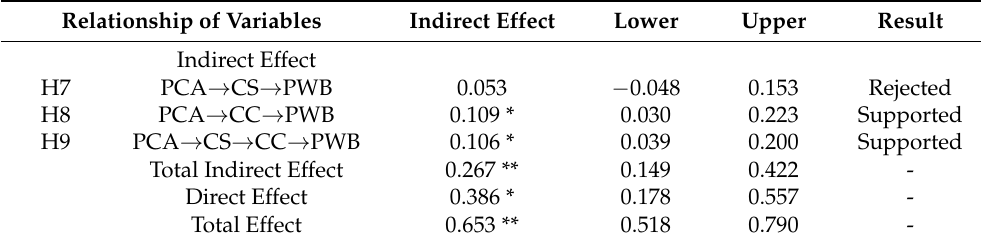
Table 5. Results of indirect effect analysis of the proposed model. Relationship of Variables Indirect Effect Lower Upper Result Indirect